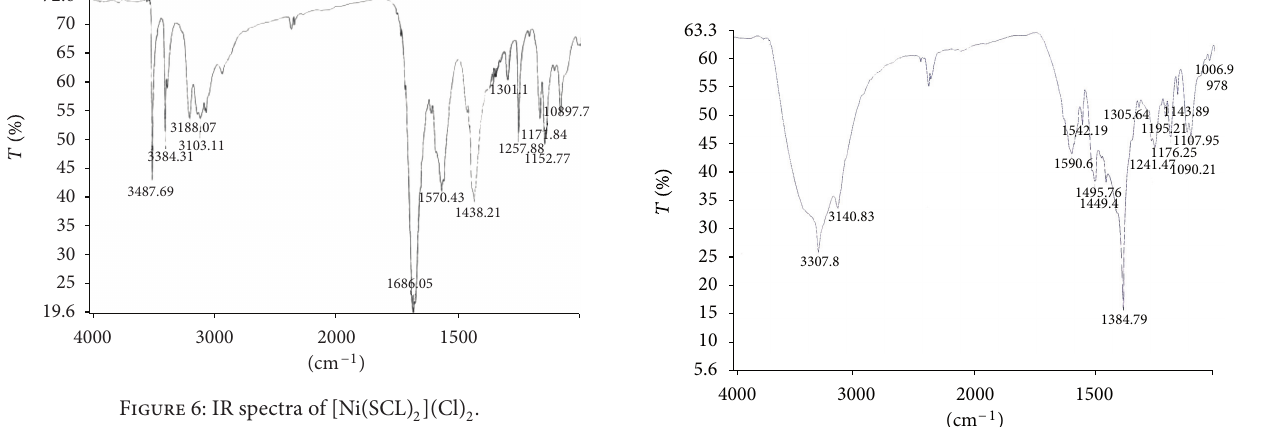
F 6: IR spectra of [Ni(SCL) T 2: Magnetic moment and electronic spectral data of com- plexes. Electronic spectral data